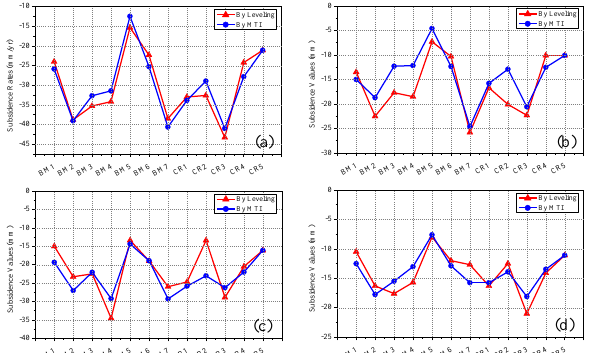
Figure 7. Comparison between subsidence results derived from leveling and from the MTI solution at seven BMs and five